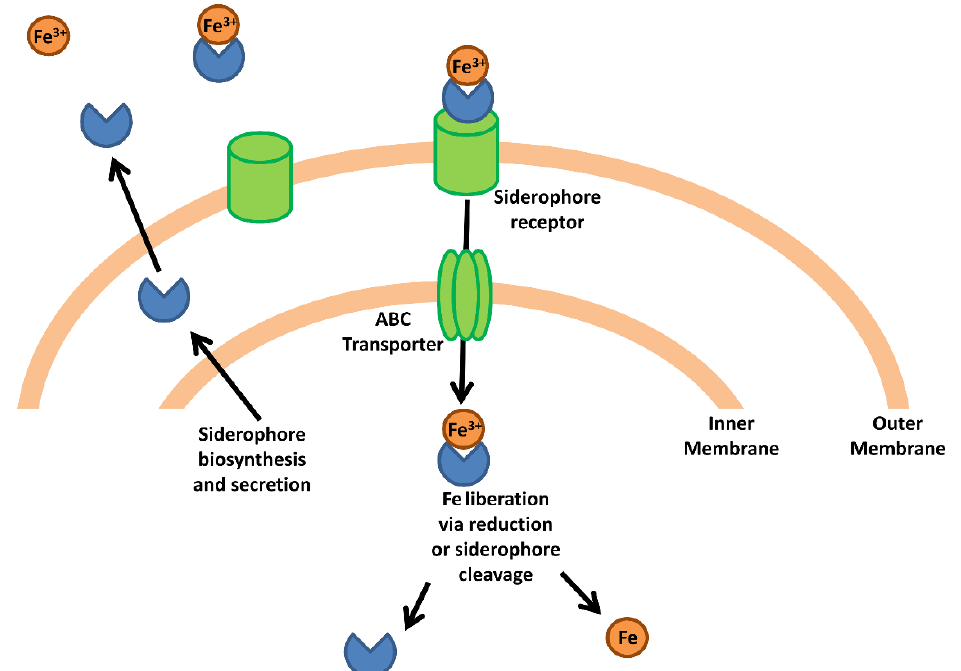
Figure 1. Bacterial iron acquisition via siderophores. The schematic represents a generic siderophore-mediated iron acquisition system based on common features in Gram-negative species. Siderophores are synthesized and secreted from the bacterial cell where they capture free iron or strip iron complexed to host proteins. The siderophore-iron complex binds a siderophore-specific receptor on the bacterial cell surface and is transported through the extracellular membrane. An ABC transporter transports the siderophore-iron complex into the cytoplasm where the complex is dissociated via reduction or enzymatic cleavage of the siderophore, releasing the iron atom into the intracellular iron pool.